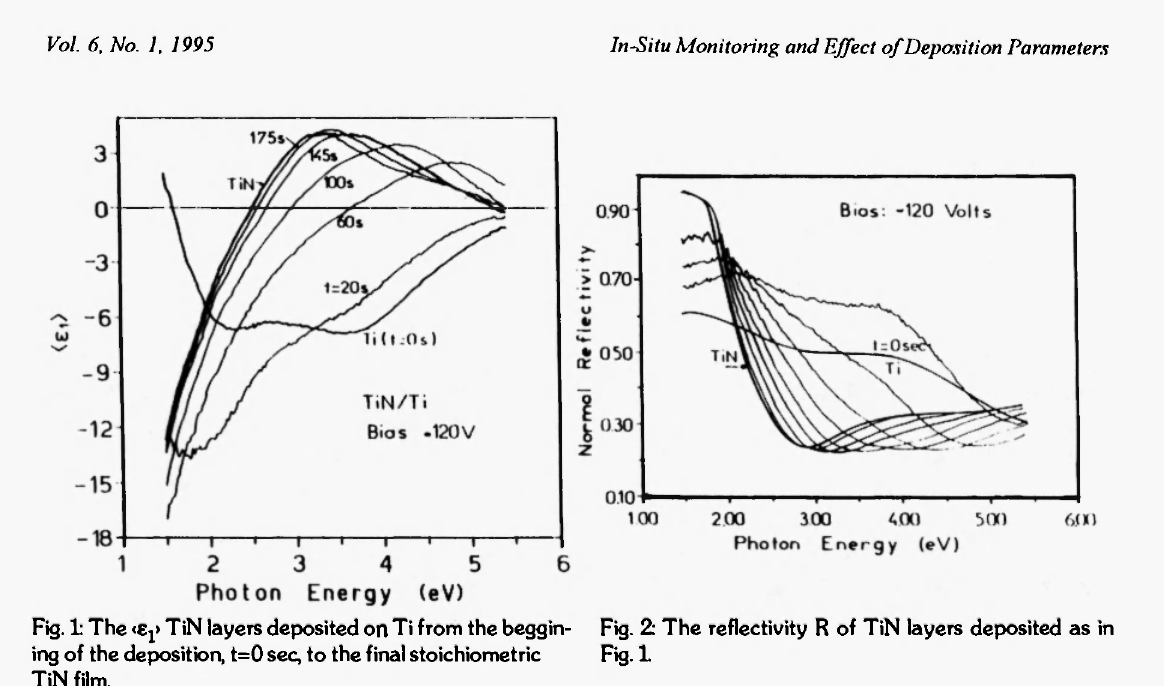
Fig. l· The <6j> TiN layers deposited on Ti from the beggin- Fig. 2: The reflectivity R of TiN layers deposited as in ing of the deposition, t=0 sec, to the final stoichiometric Fig. 1 TiN